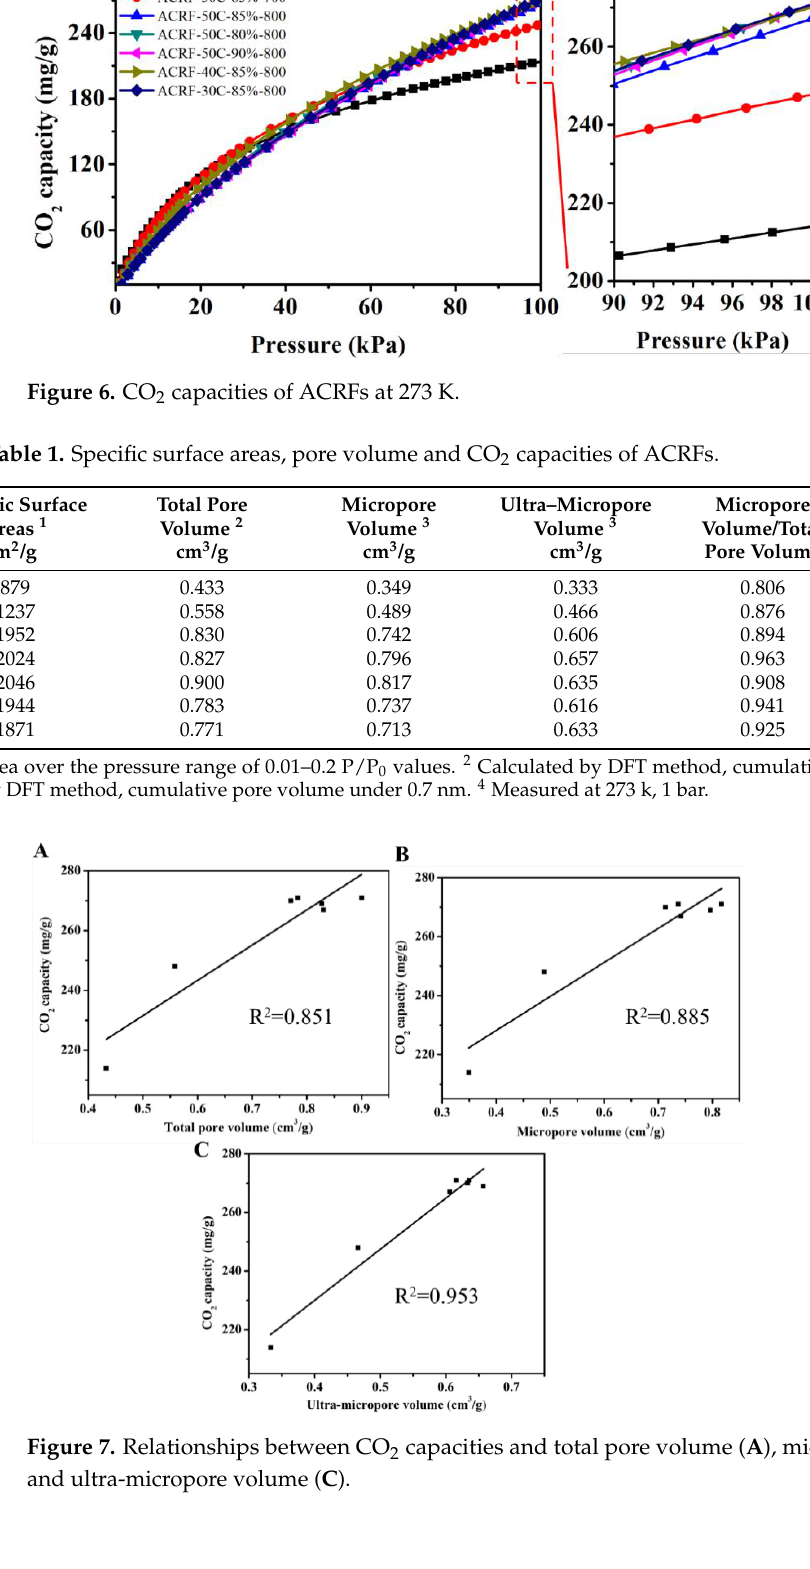
Table 1. Specific surface areas, pore volume and CO 2 capacities of ACRFs.